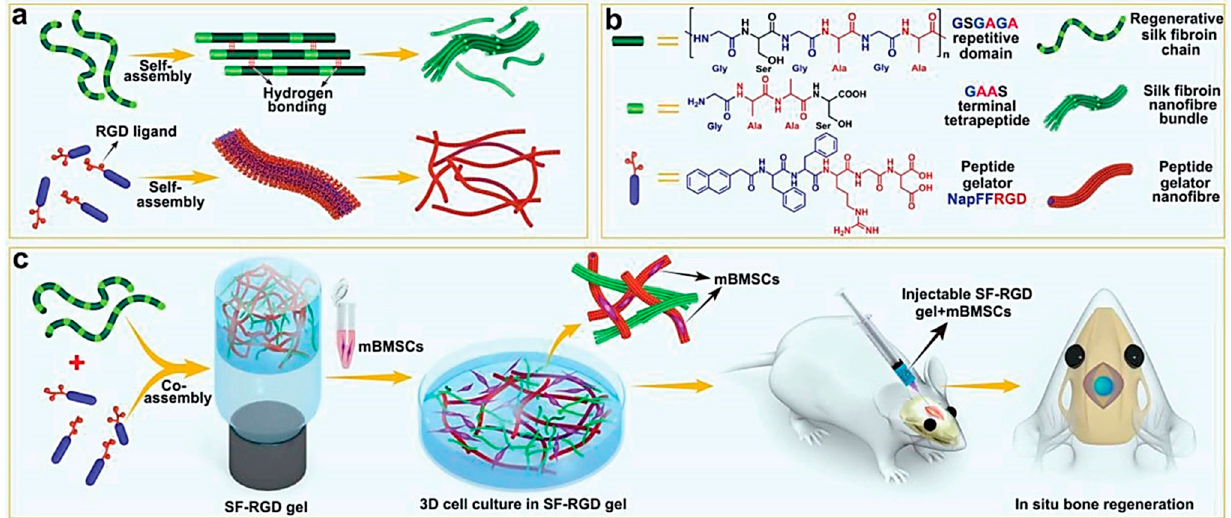
Figure 2. ( a , b ) Molecular structures and self-assembling properties of peptide gelator (Nap-FFRGD) and silk fibroin (SF) for the formation of nanofiber and nanofibril bundle structures individually; ( c ) illustration of the preparation process for SF-RGD gel from Nap-FFRGD and SF, and its biological functions to enhance osteogenesis of encapsulated mBMSCs for bone regeneration in calvarial defect areas of mice. Reprinted with permission from [67], © 2022 WILEY-VCH Verlag GmbH & Co. KGaA, Weinheim.